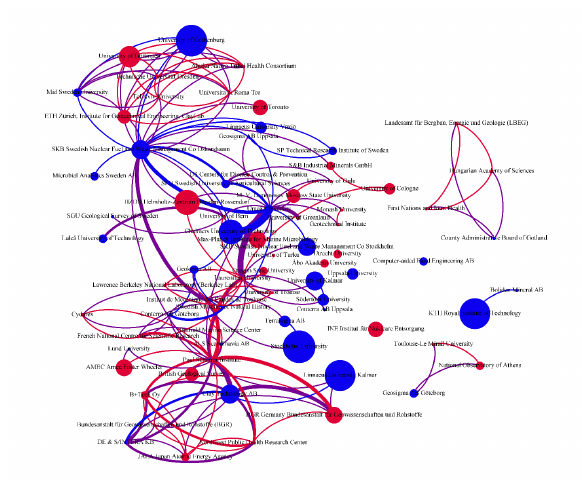
Figure 10: Research networks resulting in academically published articles linked to the ¨Asp¨o Hard Rock Laboratory according to organization